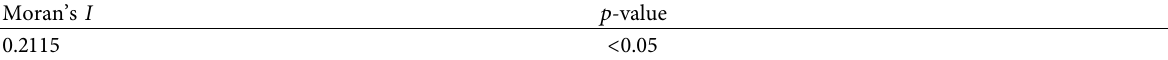
Table 5: Result of global Moran’s I